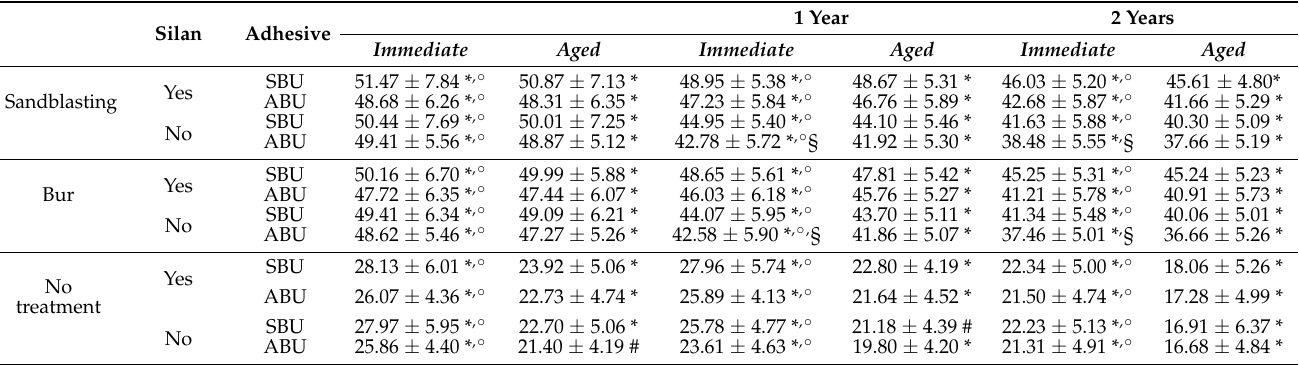
Table 4. The means and standard deviations ( µ TBS in MPa ± SD) of repair strength of nanohybrid resin composite for all experimental